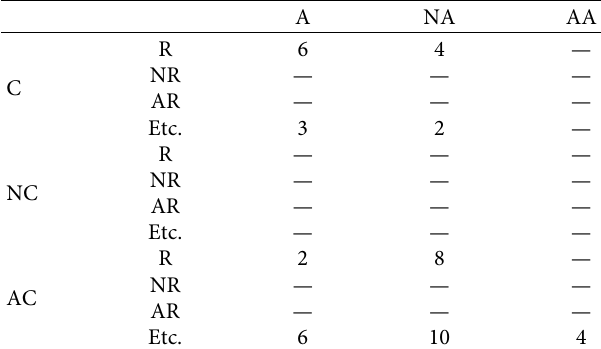
Table 1: Classification of the hypergroupoids of order 2.